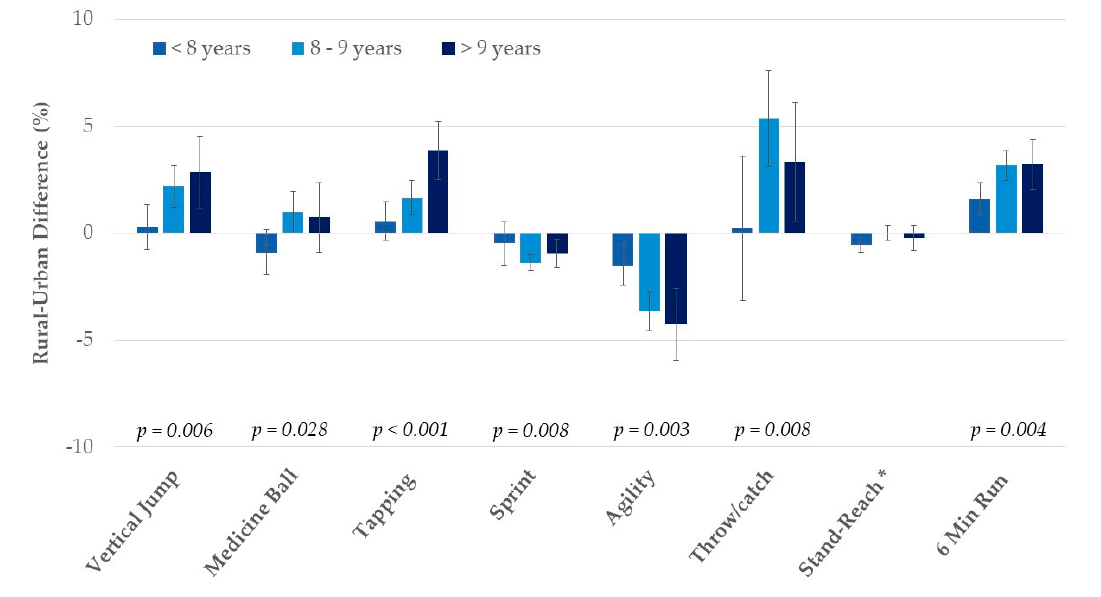
Figure 1. Rural–urban differences by age group. Values are mean differences, adjusted for sex with 95% CI, and p -values reflect significance for age-by-living area interaction.